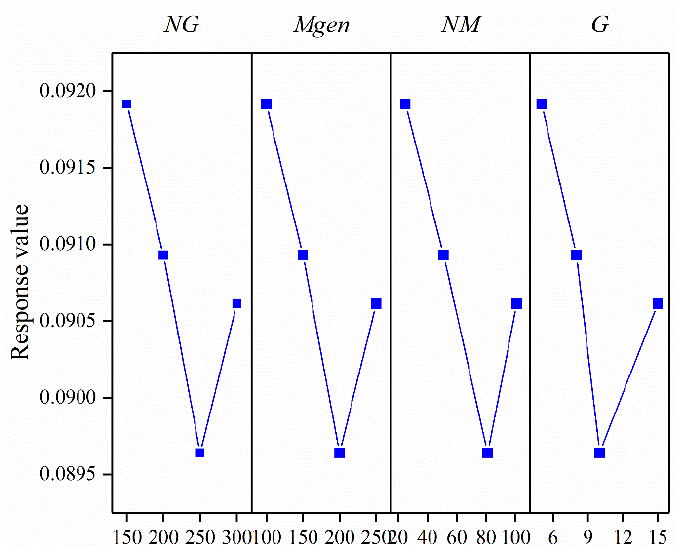
15 Table 4. Orthogonal matrix and response value.